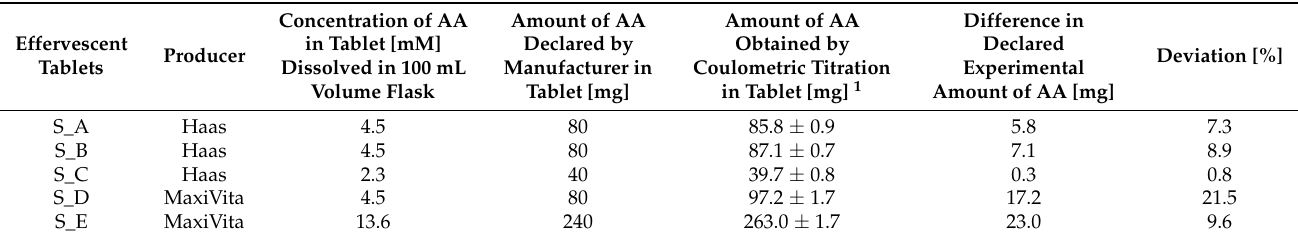
Table 4. Comparison of ascorbic acid (AA) in effervescent tablet samples (labeled S_A–S_E) specified by the manufacturer on the packaging label and experimentally determined using coulometric titration for n =